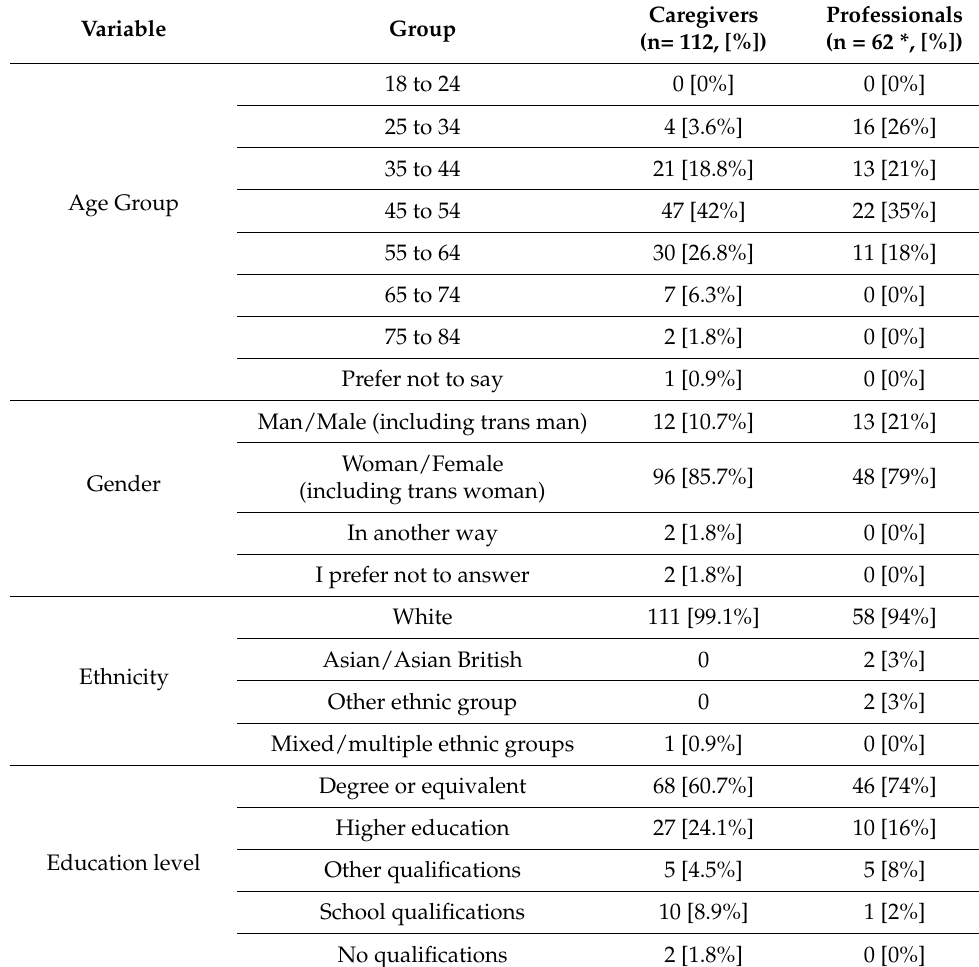
Table 1. Participant Demographics. * n = 61 for professionals’ gender